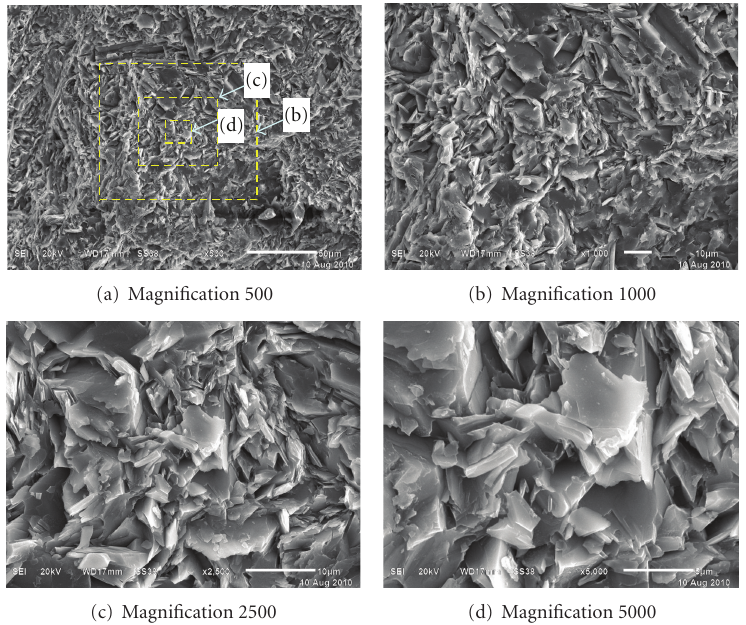
Figure 2: SEM images of grey diabase with di ff erent magnifications.